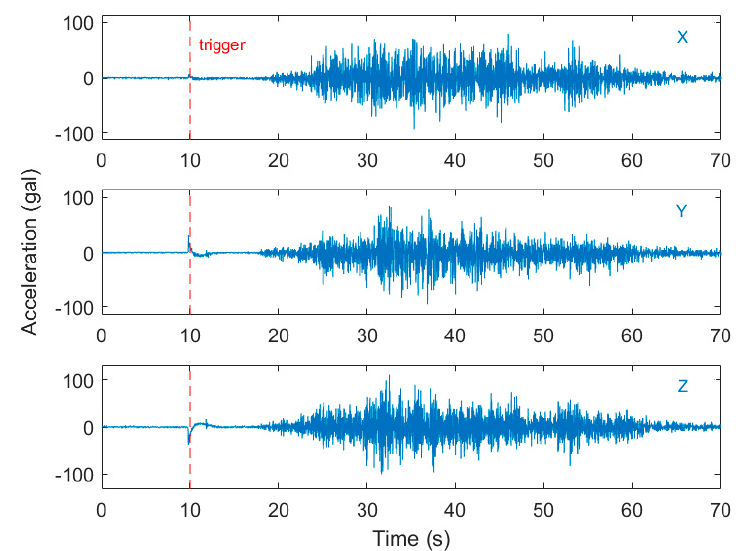
Figure 8. The typical case of false classification during the shake table test of the Samoa Islands earthquake in the first dataset (worldwide earthquakes). The trigger started some seconds before the arrival of the p -wave due to noise signals at rest. (vertical component).